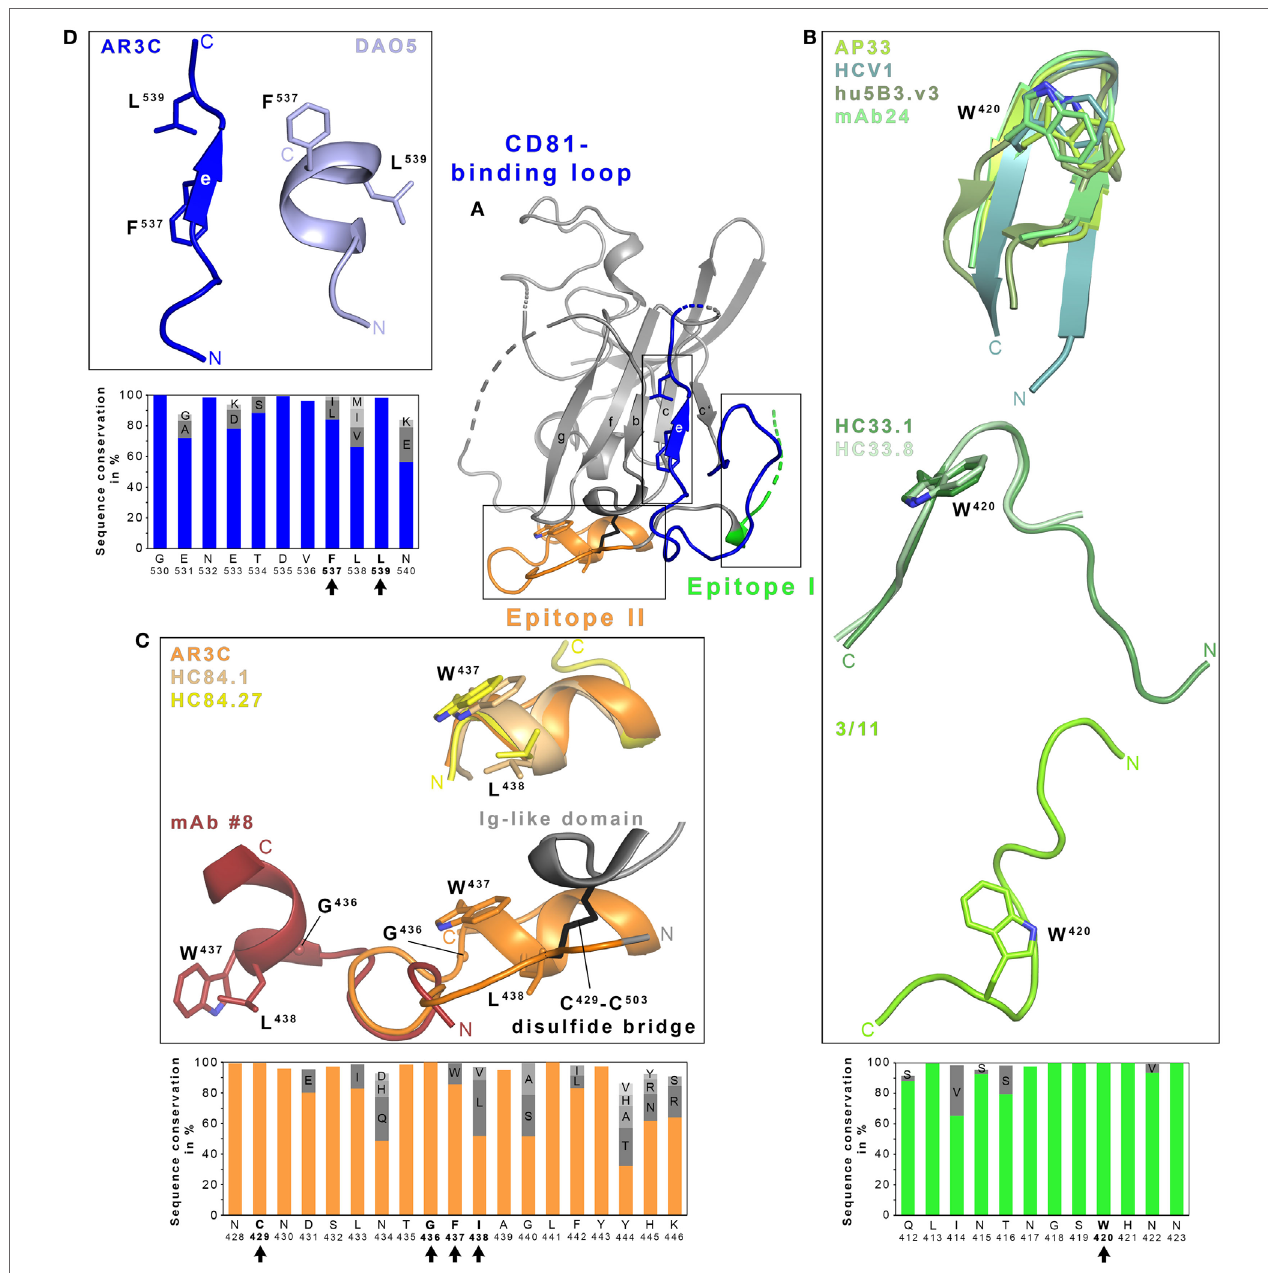
FiGURe 1 | Structural flexibility of the hepatitis C virus (HCV) E2 glycoprotein. (A) Cartoon representation of the E2 ectodomain crystallized in complex with AR3C Fab (PDB 4MWF). The composite CD81-binding site consisting of epitope I (aa412–423; green), epitope II (aa428–446; orange), and the CD81-binding loop (aa518–542; blue) is highlighted in color and sidechains of selected residues are displayed as sticks. (B–D) Close-up views of the three antigenic sites mentioned above. (B) Epitope I is disordered in the context of the E2 structure but a synthetic epitope peptide folds as β -hairpin in complex with neutralizing antibodies (nAbs) AP33 (PDB 4GAJ), HCV1 (PDB 4DGV), hu5B3.v3 (PDB 4HS8), and mAb24 (PDB 5VXR) (upper panel). By contrast, the same peptide adopts two distinct extended conformations in complex with nAbs HC33.1 (PDB 4XVJ) and HC33.8 (PDB 5FGC) (middle panel) or 3/11 (PDB 4WHY; bottom panel), respectively. The peptide in the nAb HC33.4 complex (PDB 5FGB) adopts an amino acid backbone conformation identical to the one in complex with nAb HC33.8 and is not shown for simplicity. (C) Superposition of the epitope II peptide structure in complex with HC84.1 and HC84.27 Fabs (PDB 4JZN and 4JZO, respectively) onto the E2 ectodomain structure (upper panel) reveals a conserved 1.5-turn α -helix (aa437–442) with an extended C-terminal segment containing aa443–446. Superposition of the N-terminal loop of epitope II (aa430–434) from the peptide structure in complex with mAb #8 (PDB 4HZL) onto its counterparts in the E2 structure suggests that the short α -helix flips out to expose residues W 437 and L 438 for mAb #8 binding (bottom panel). (D) Residues 532–540 of the CD81-binding loop were observed in an extended conformation in the context of the E2 ectodomain structure (A) and in a helical conformation in the DAO5 Fab–E2 peptide complex structure (PDB 5NPJ) suggesting thereby a putative open and closed conformation of the immunoglobulin-like domain. Amino acid sequence conservation of the respective antigenic site was calculated across the six HCV genotypes for 481 isolate sequences (100 sequences each for genotypes 1, 2, 3, 6, and 70, 9 and 2 sequences for genotypes 4, 5, and 7, respectively) obtained and analyzed from the ViPR database (http://www.viprbrc.org) and is shown below each close-up view. Residues with side chains shown as sticks are highlighted by black arrows.